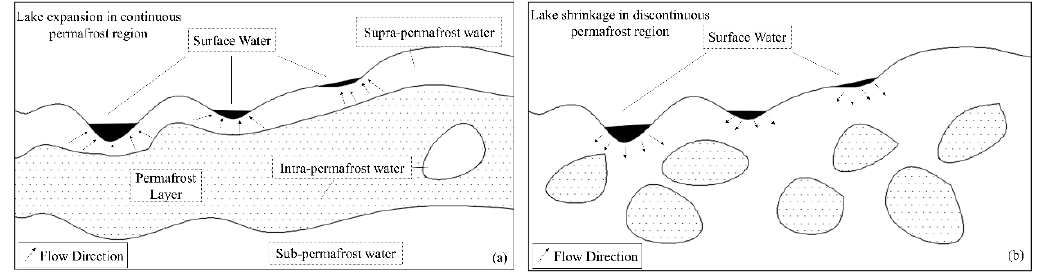
Figure 13. Changes of lakes in ( a ) continuous permafrost region and ( b ) discontinuous permafrost.